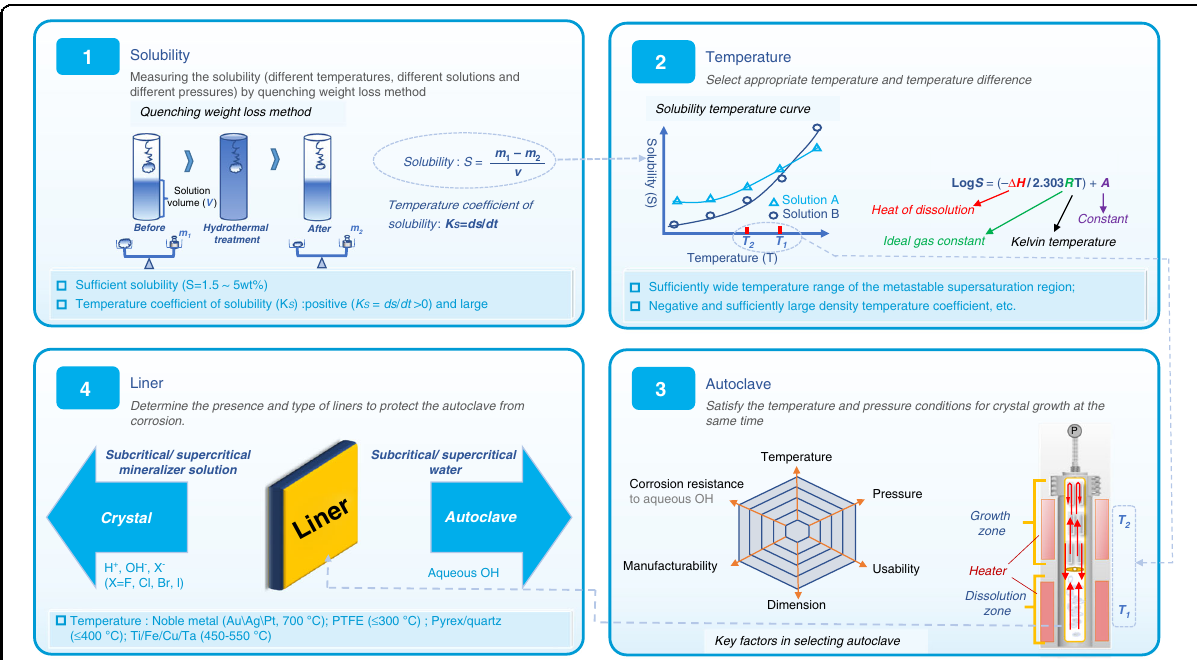
Fig. 3 Pre-work of hydrothermal bulk crystal growth. Before growing crystals by hydrothermal method, the following four tasks should be done fi rst: measuring the solubility (different temperatures, different solutions, and different pressures); select appropriate temperature and temperature difference; select an autoclave to meet the crystal growth requirements; determine the presence and type of liner according to the